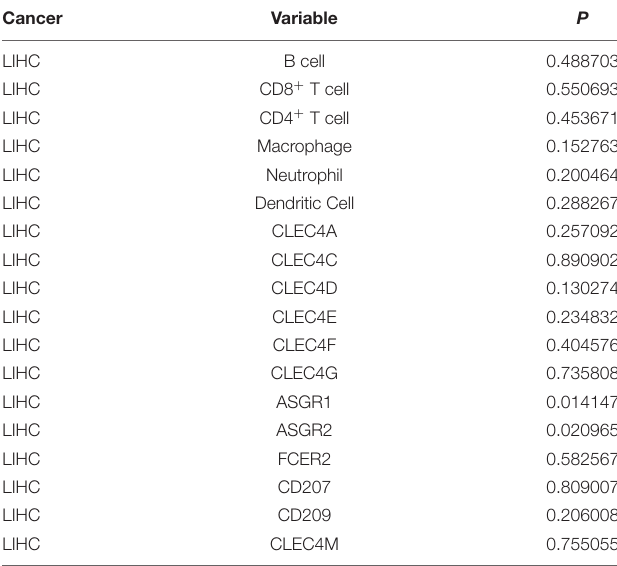
TABLE 2 | The cox proportional hazard model of CLEC4s and six tumor-infiltrating immune cells in LIHC (TIMER). Cancer Variable